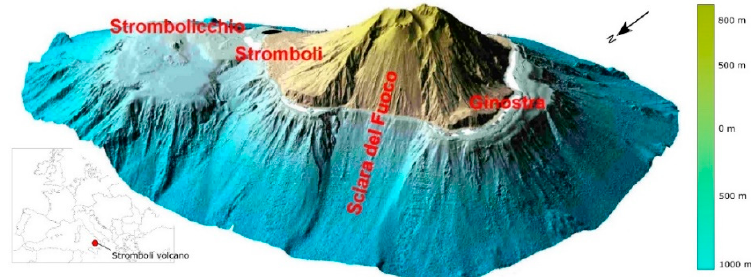
Figure 8. Digital Terrain and Marine Model of Stromboli volcano (Tyrrhenian Sea) showing the Sciara del Fuoco landslide (modified after Chiocci et al. [82]).